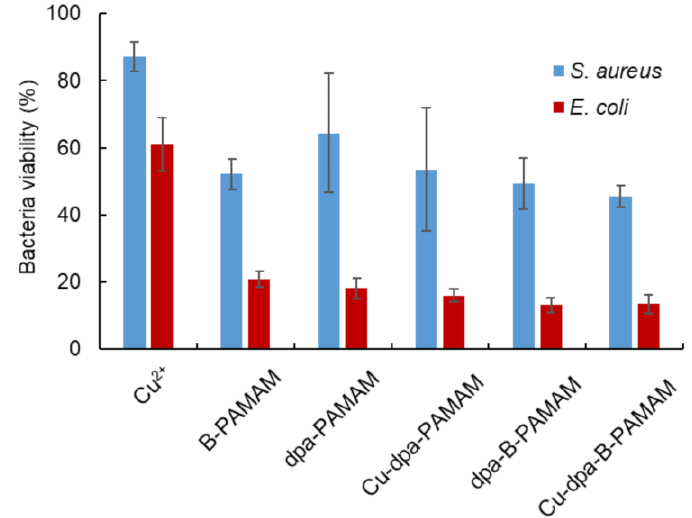
Figure 7. Bacteria viability at pH 7.4 measured by MTT assay ( λ abs = 560 nm, n = 3). [probe] = 3.3 µ M or none; [Cu 2+ ] = 13.2 µ M or none; [ S. aureus ] = 5.0 × 10 7 CFU · mL − 1 ; [ E. coli ] = 2.3 × 10 8 CFU · mL − 1 ; [HEPES] = 5.0 mM. Bars are expressed as SD for three separate experiments. The viability of S. aureus could be discriminated from the results in E. coli ( p < 0.05). The viability of suspensions contains Cu 2+ could be discriminated from the suspensions containing other probes ( p <